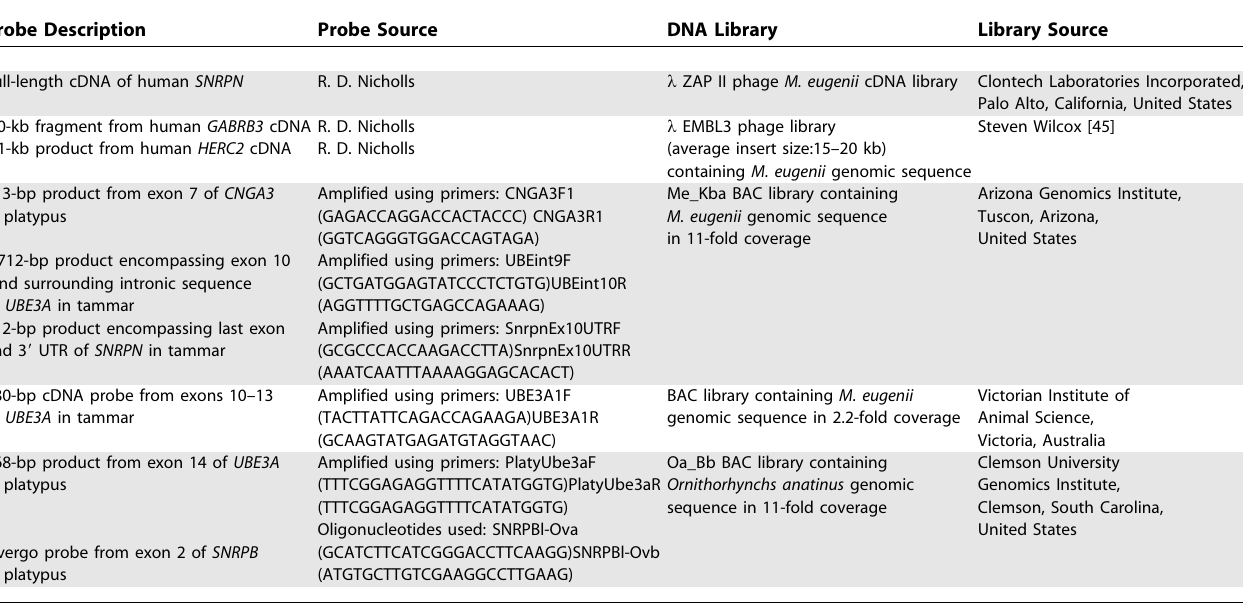
Table 2. Description of Probes Used and DNA Libraries Screened